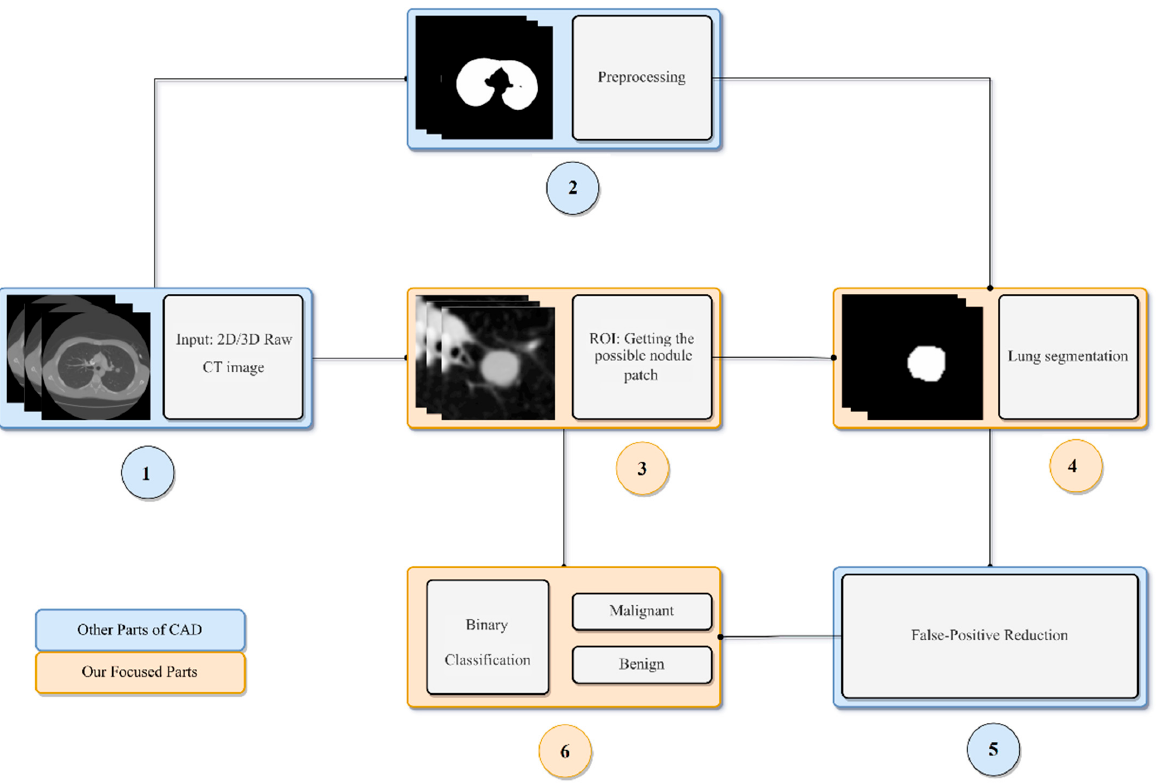
Figure 1. A general pipeline of a lung nodule CAD system.